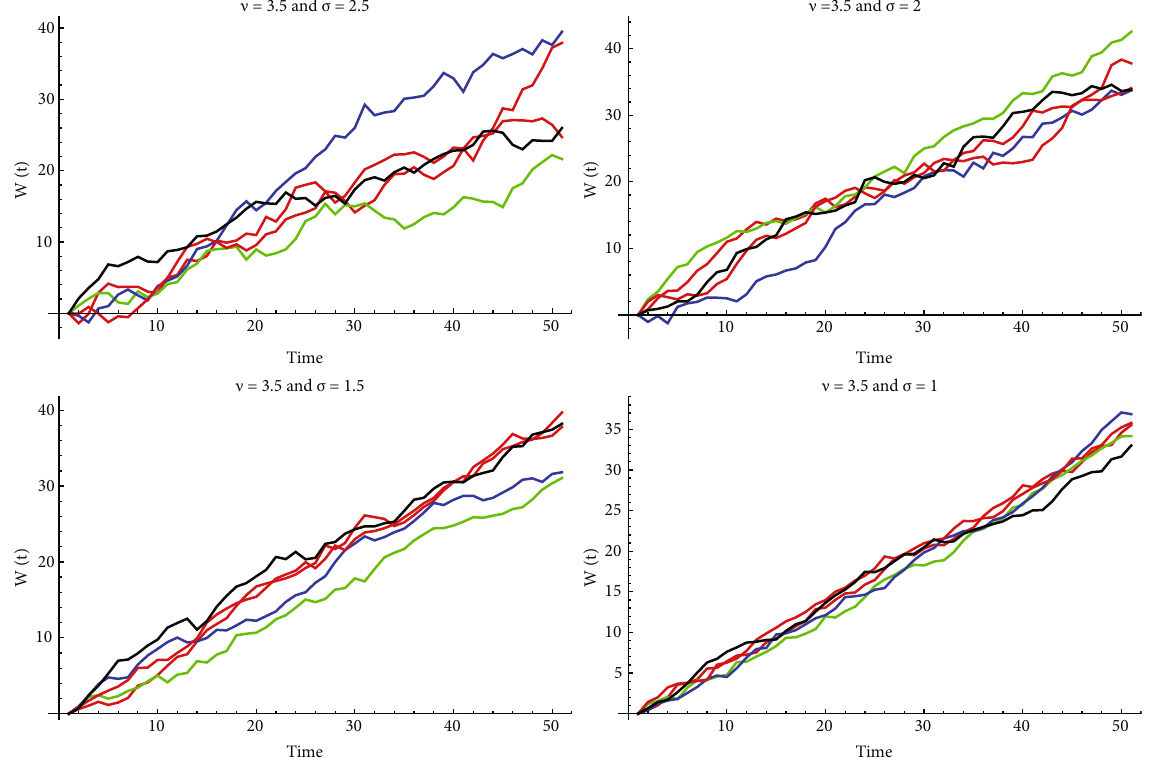
Figure 1: Simulated Wiener process sample paths.